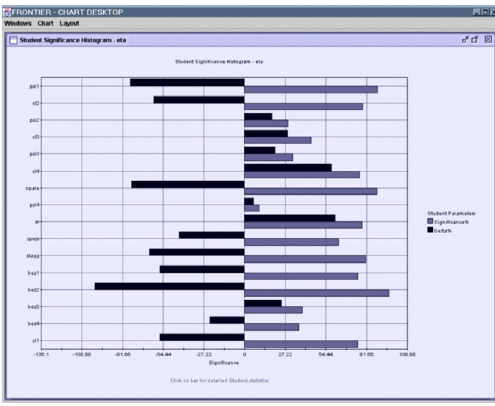
Figure 3: Significance of the variables in step